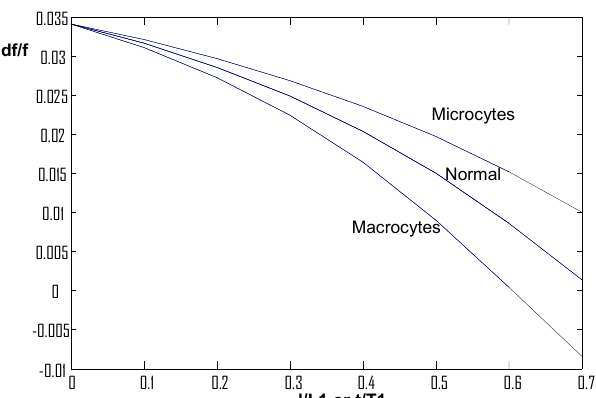
Fig.5: Responses of microcytes and macrocytes as compared to the normal volume of RBCs.